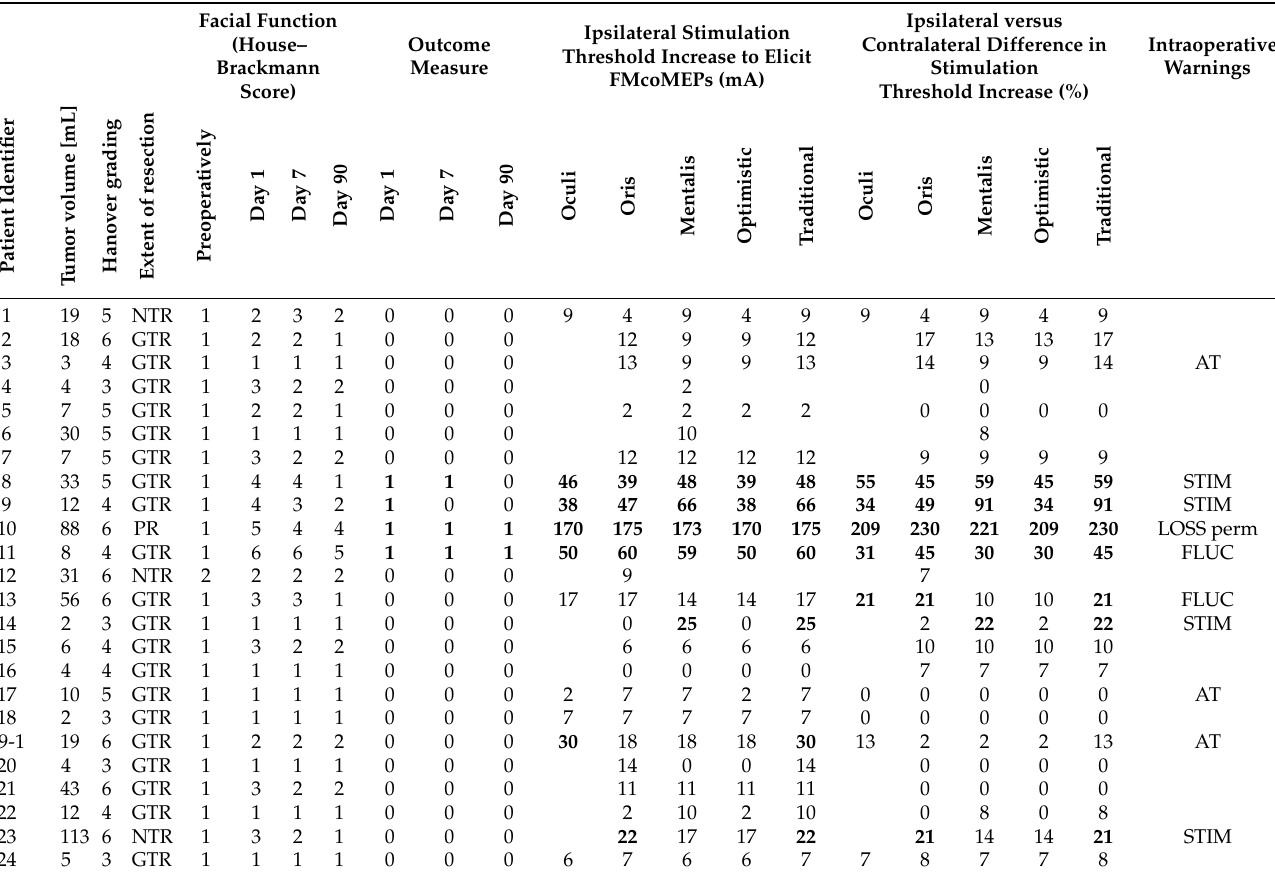
Table 3. Patient